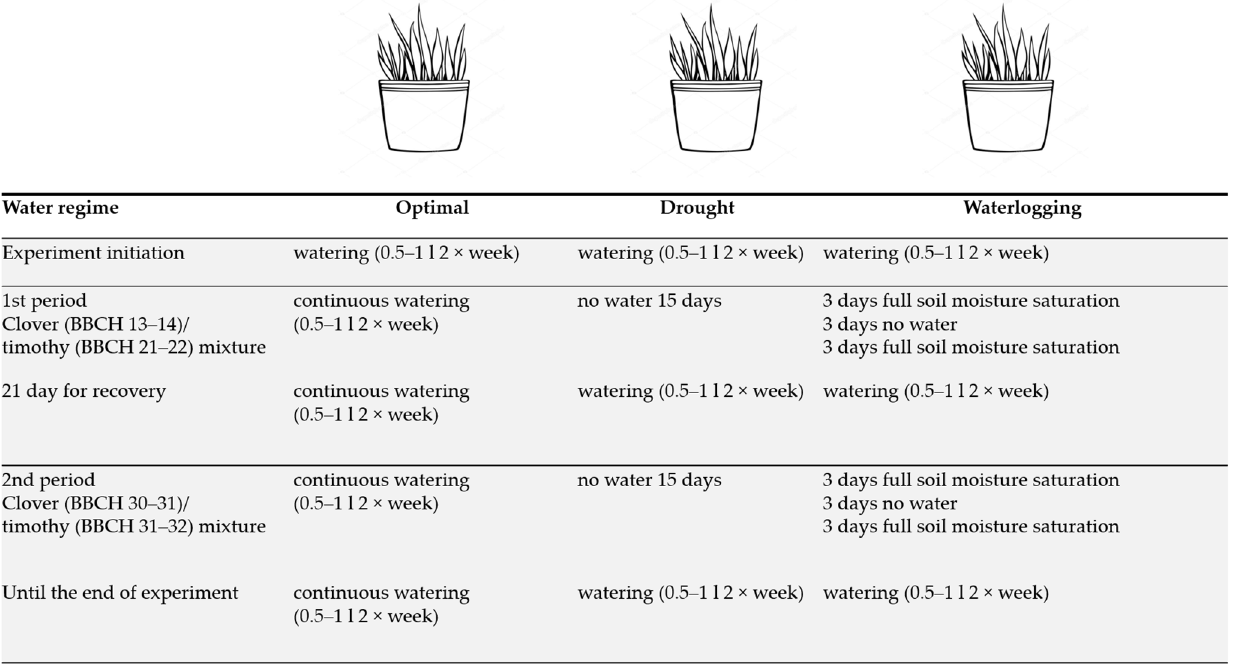
Figure 2. Experiment design of water regime.